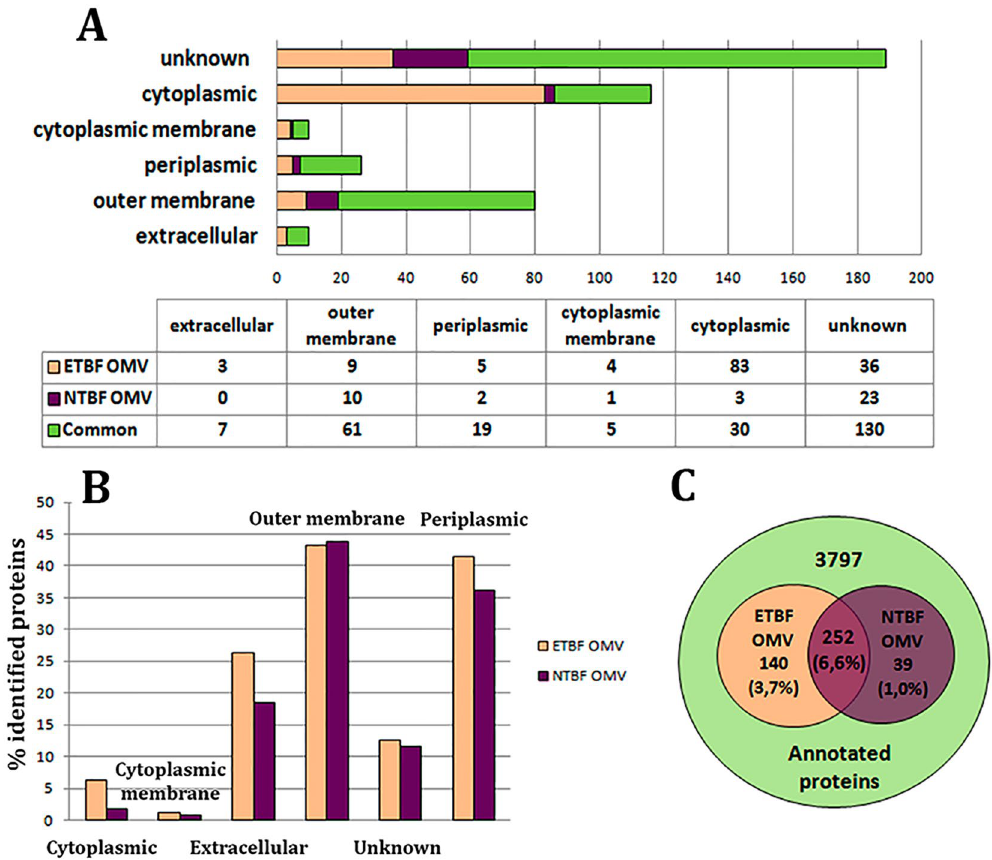
Figure 1. Distribution of the identified OMV proteins according to their subcellular localization. ( A ) Predicted subcellular localization of the proteins isolated from ETBF and NTBF OMVs according to PSORTb 3.0. ( B ) Percentages of the proteins identified in both types of vesicles relative to the total number annotated for B. fragilis proteins according to their subcellular localization. ( C ) The Venn diagram shows the comparative analysis and individual differences of the number of proteins identified in both types of vesicles relative to the total number annotated for B. fragilis